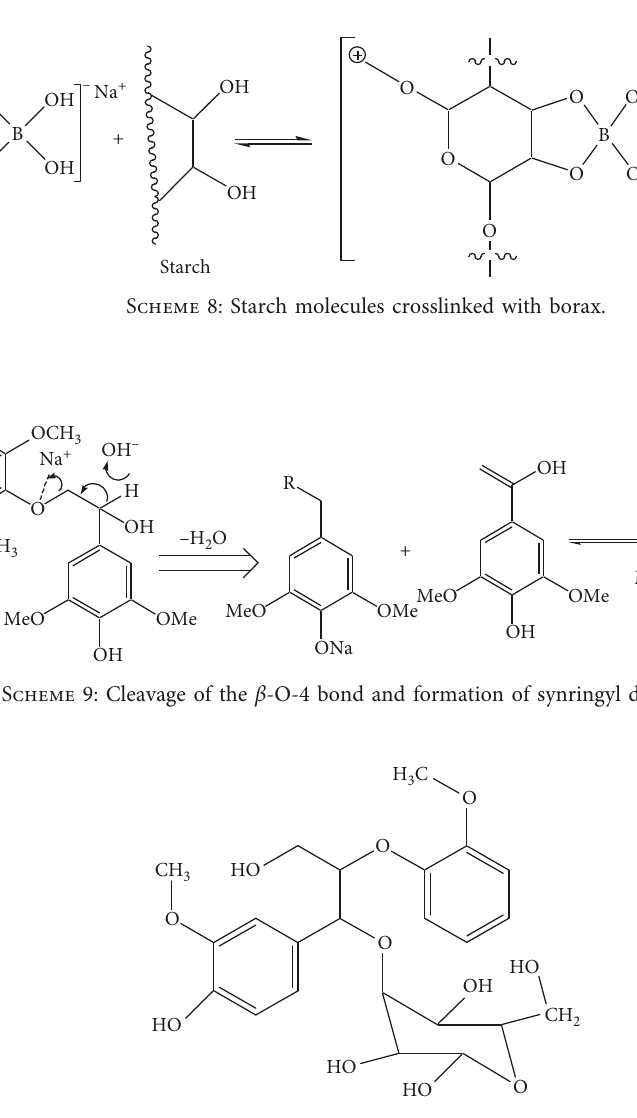
Figure 1: Ether bond formed between starch and lignocellulose